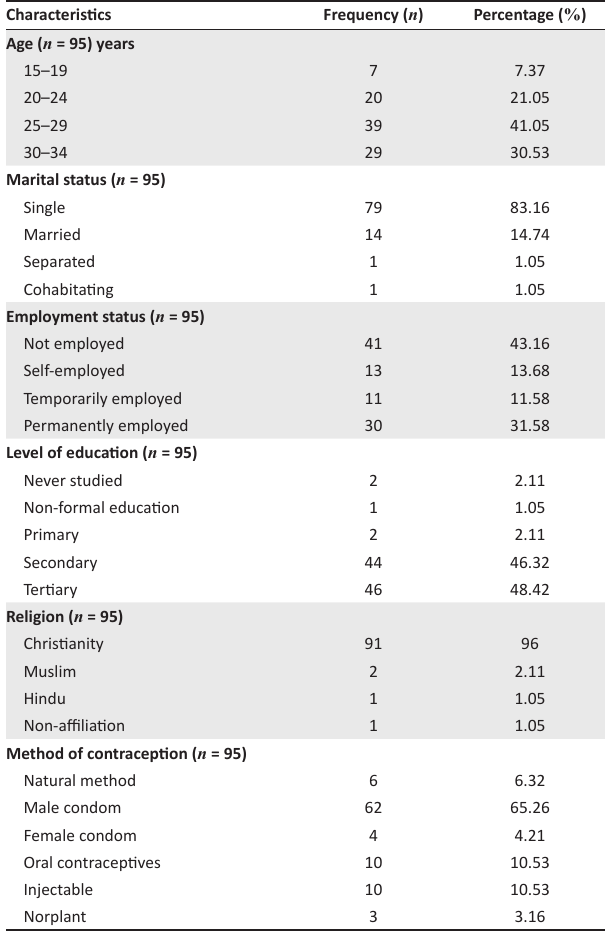
TABLE 1: Socio-demographic characteristics of